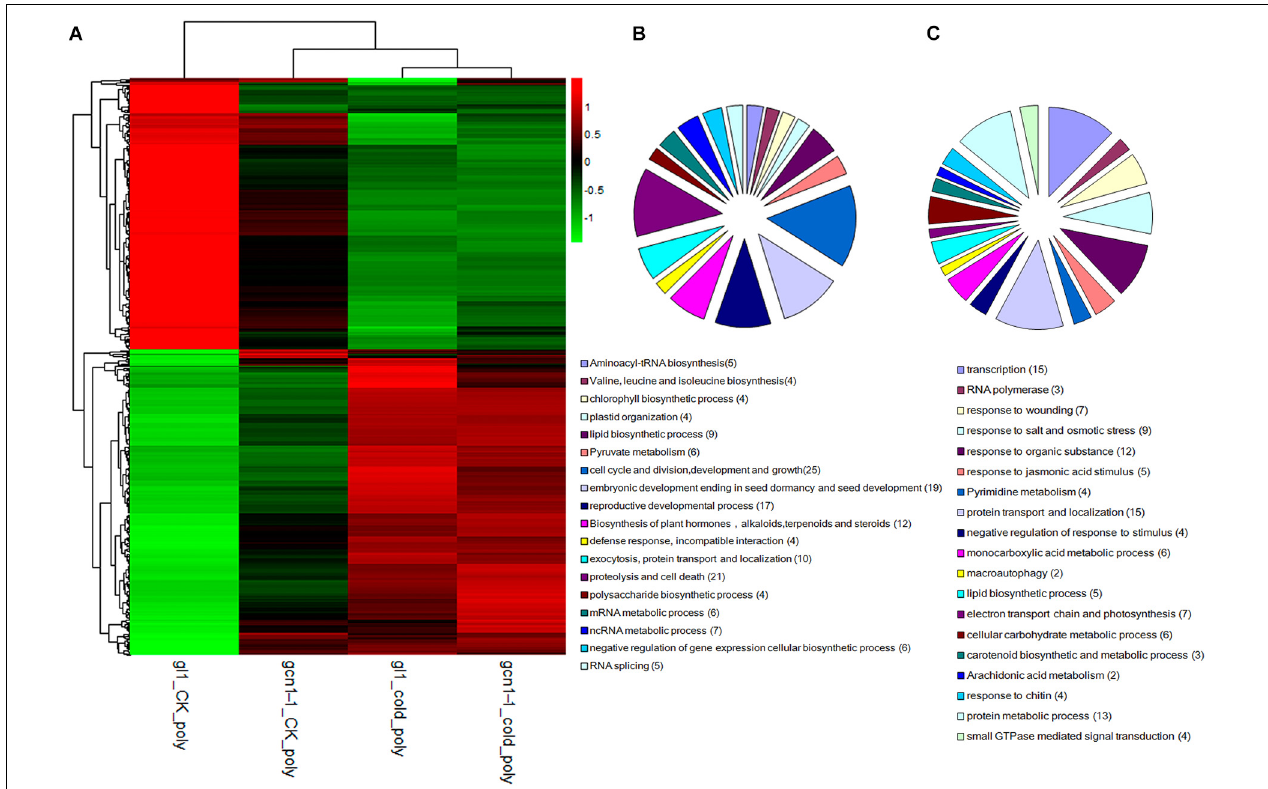
FIGURE 4 | eIF2 α phosphorylation selectively regulates protein translation under cold stress conditions. (A) Hierarchical clustering analysis of cold-ATGCN1 genes at translational levels. (B) GO terms analysis of cold-ATGCN1 genes that were down-regulated at translational levels. (C) GO terms analysis of cold-ATGCN1 genes that were up-regulated at translational